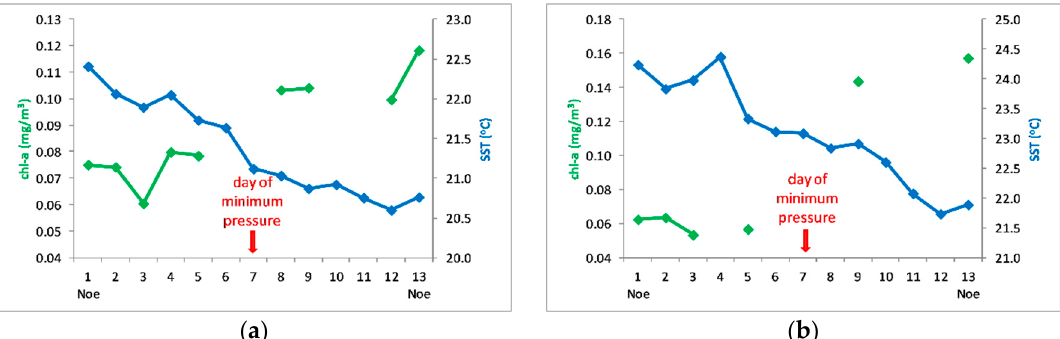
Figure 6. Mean chlorophyll concentration and SST for the time period centered on the event examined ( a ) For the 50 km width area along the cyclone’s track on 7 November 2014; ( b ) For the area of chlorophyll increase marked with P in Figure 5c.